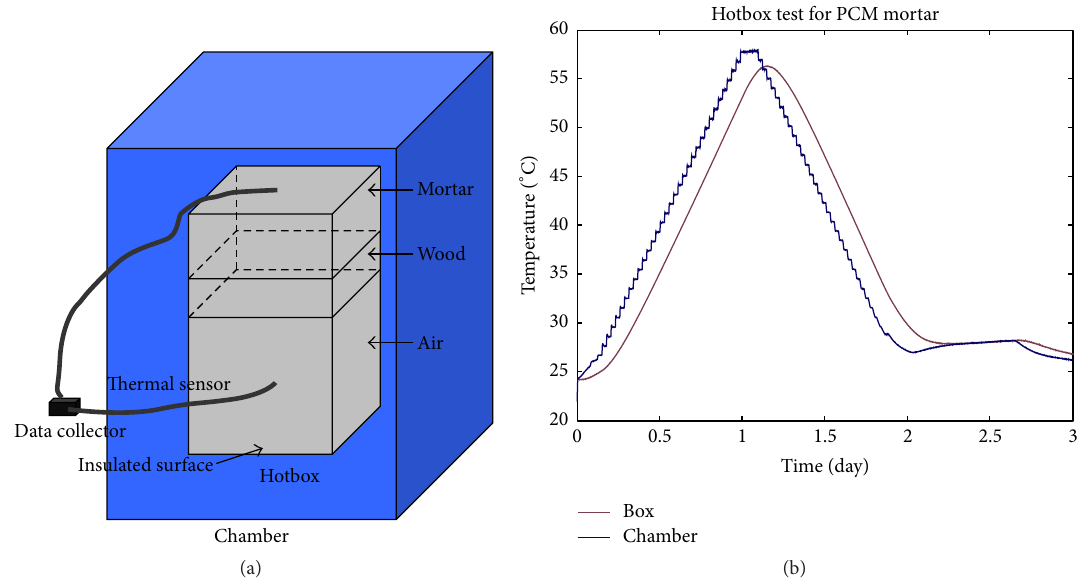
Figure 4: A heat conduction test: (a) experimental setup; (b) test results